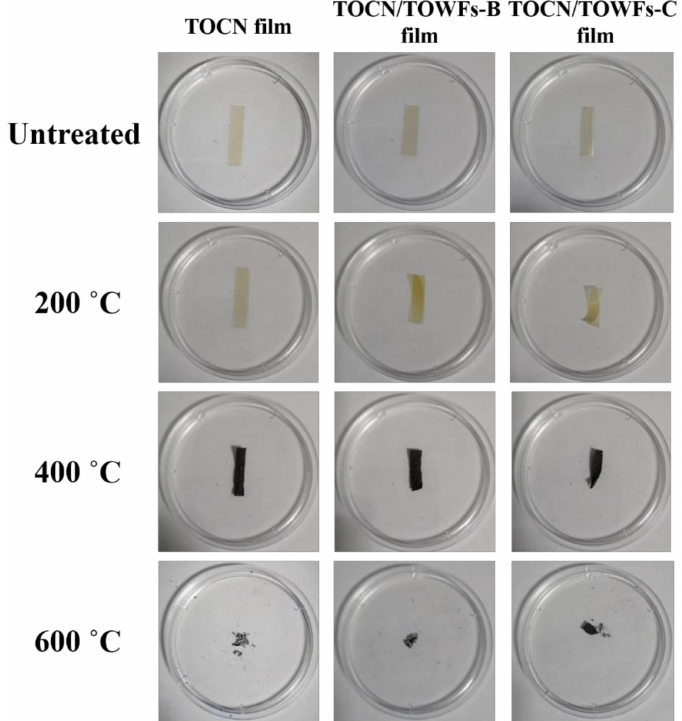
Figure 6. Thermal stability of TOCN films, TOCNs/TOWFs-B films, and TOCNs/TOWFs-C films under air atmosphere.